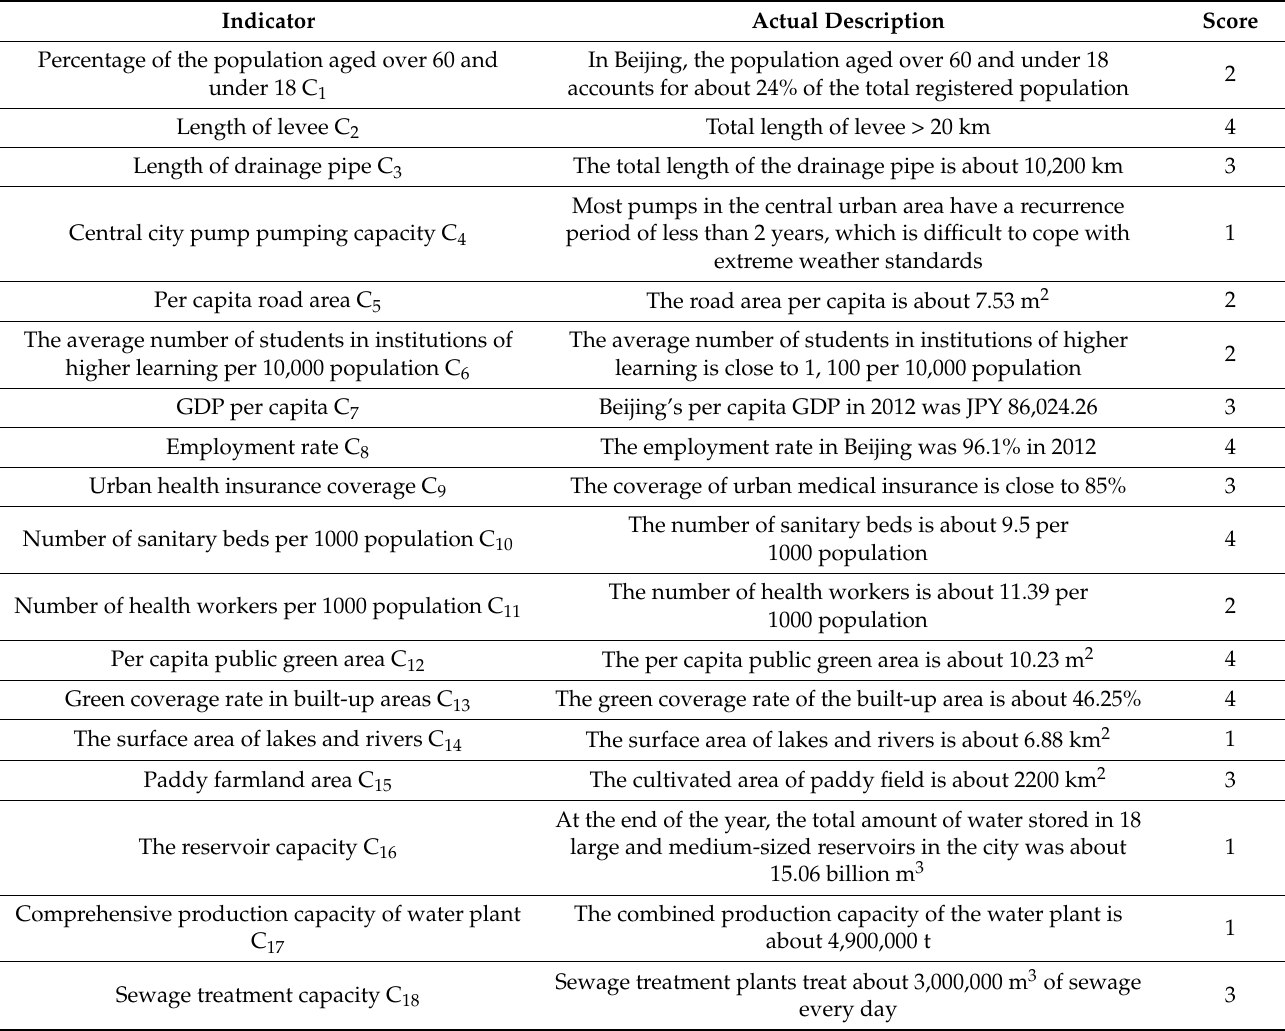
Table 15. Grade classification of stormwater resilience indicators in